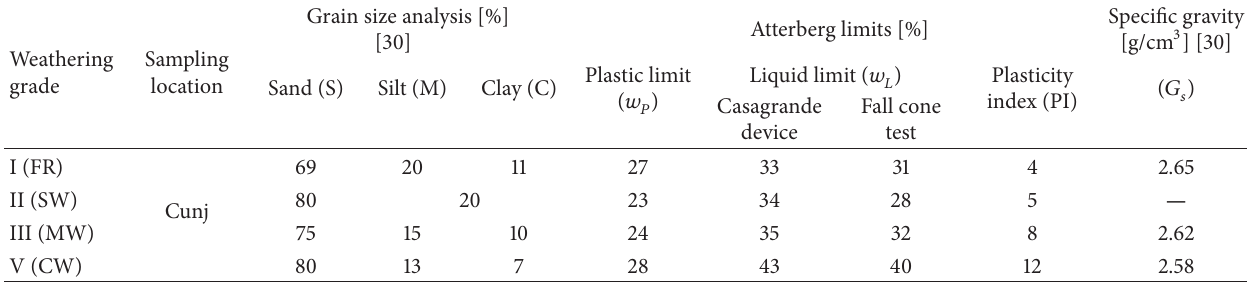
Table 2: Geotechnical properties of the siltstone samples of different weathering